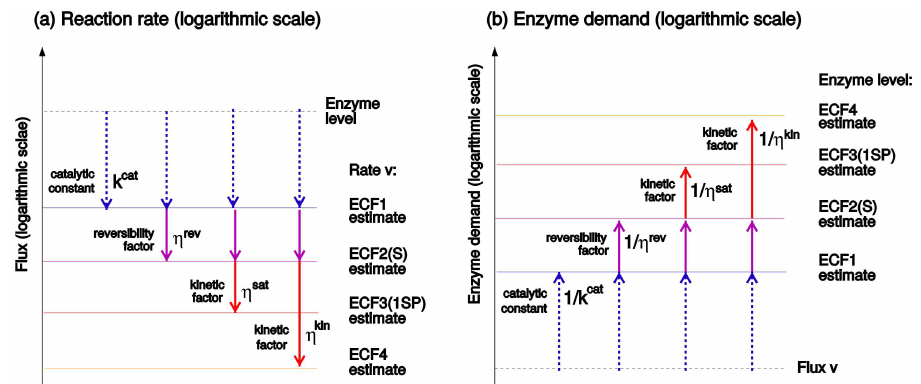
, log η rev , and log η kin , and obtain cat has a numericalvalue smaller than 1. cat